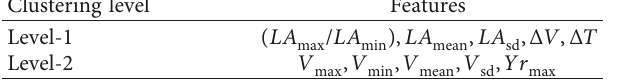
Table 4: Driving performance features used for level-wise clustering. Clustering level